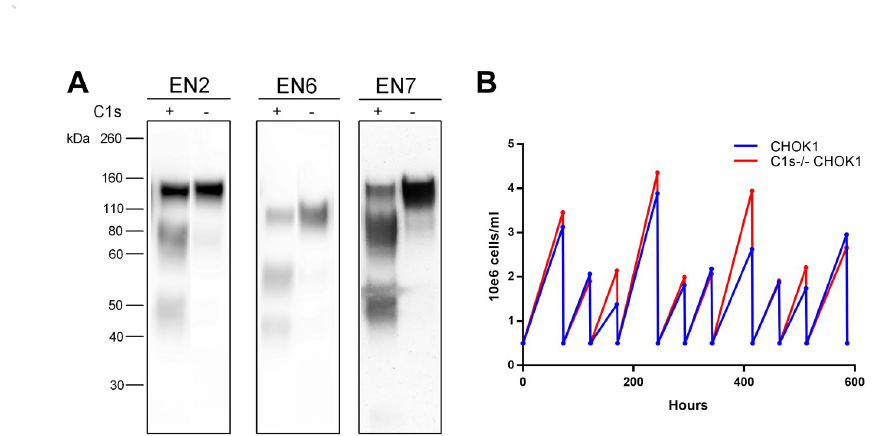
Fig 3. Characteristics of the C1s -/- CHOK1 2.E7 cell line. A. Comparison of proteolysis of clade B gp120s expressed in CHO cells with and without the presence of C1s. EN2, EN6 and EN7 rgp120s were transiently transfected in the CHOK1 and the C1s -/- CHOK1 2.E7 cell line by electroporation. rgp120s expressed in the CHOK1 cell line are indicated with (+) and those expressed in the C1s -/- CHOK1 2.E7 cell line are indicated with (-). Supernatants were analyzed by immunoblot using an anti-rgp120 polyclonal antibody. Cell culture supernatant was assayed by immunoblot with a goat polyclonal serum to gp120. B. The viable cell densities, or VCD, plotted against time for the CHOK1 cell line and the C1s -/- CHOK1 2.E7 cell line. VCD was counted prior to splitting cells every two or three days for ten